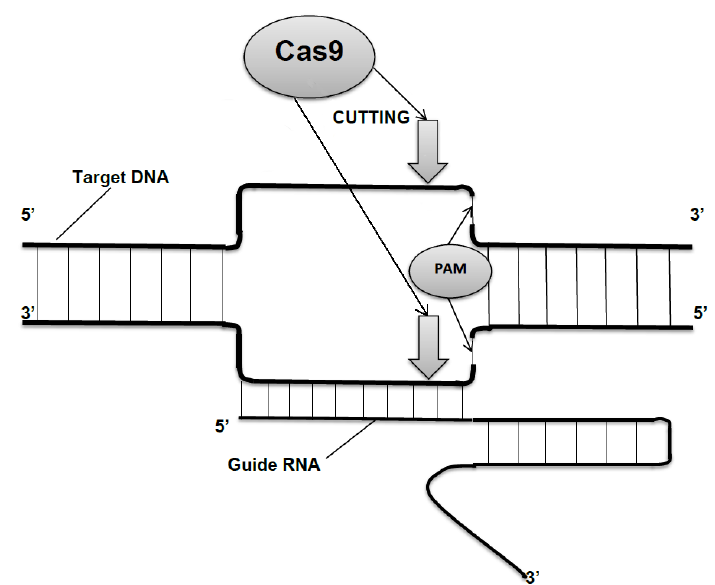
Fig. 1. The components of the CRISPR/Cas9 system. Guide RNA attaches specifically to the DNA fragment. Cas9 (CRISPR- associated protein 9) is an endonuclease that can cut the double-stranded DNA. This process requires PAM (protospacer adjacent motif) – a specific sequence of DNA located at the 3’ end of the RNA guide. DNA repair after sectioning can be done through two pathways: non-homologous end joining (which leads to a random insertion / deletion of DNA), or homology directed repair (which produces a precise editing of the